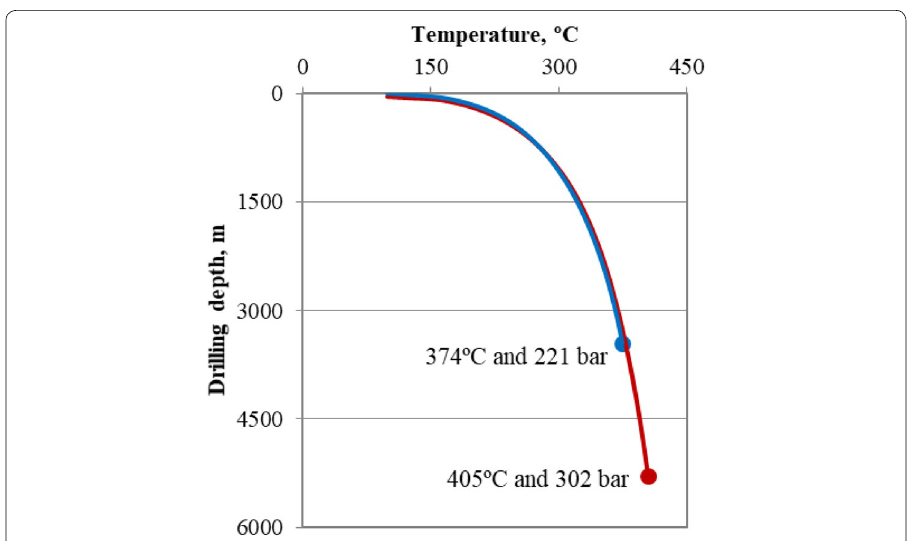
Fig. 1 Critical temperature and pressure points for pure water (blue line) and salt water (red